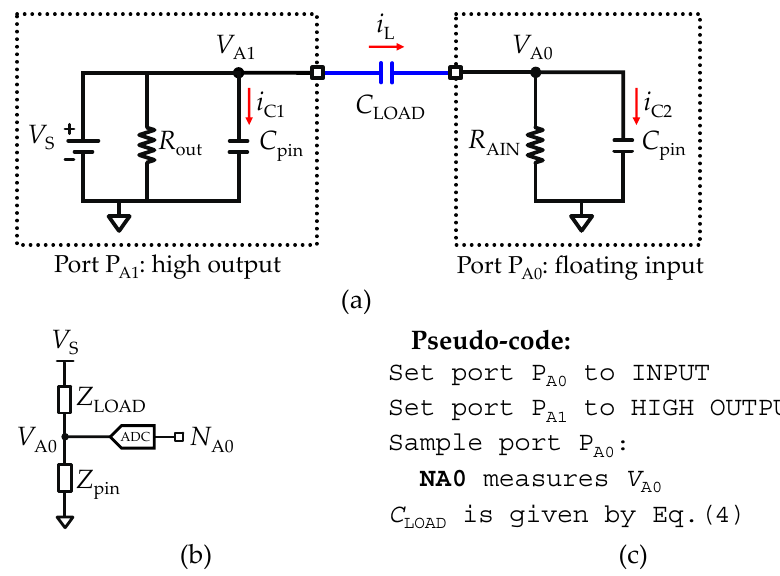
Figure 3. Set-up of a pure load capacitance meter ( C -meter). ( a ) Equivalent circuit of two analog I/O ports bridged with a load capacitance (C LOAD ). ( b ) Reduction of the equivalent circuit to an impedance divider. ( c ) Pseudo-code used to implement the fast acquisition mode.